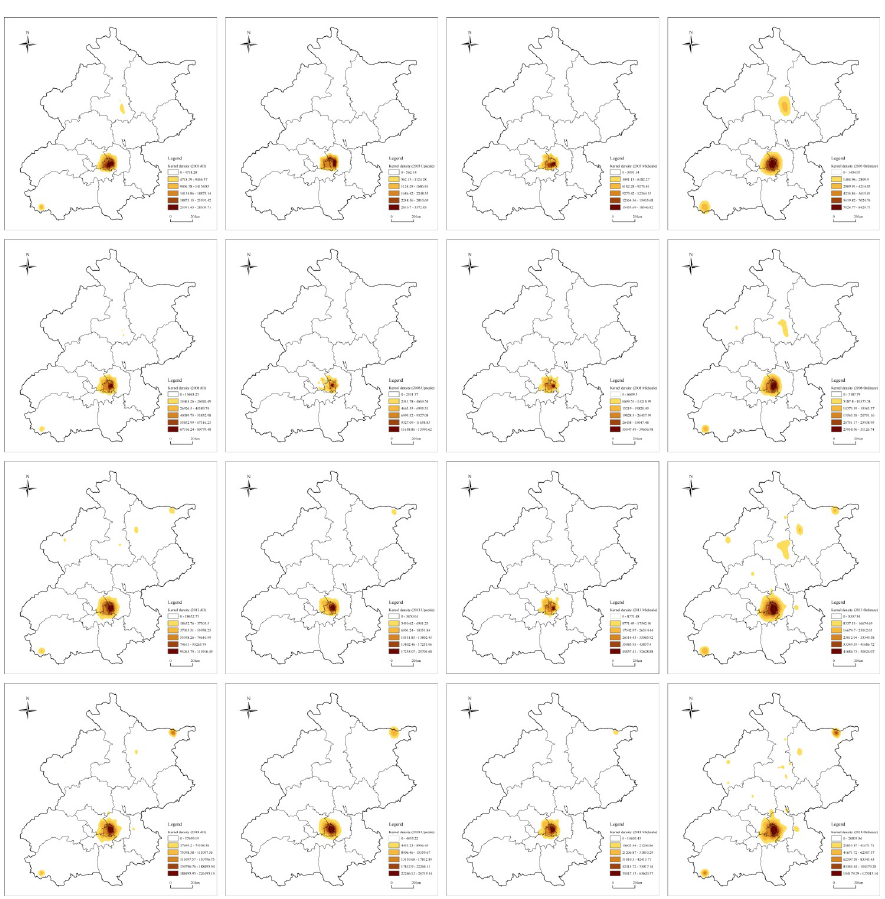
Fig 4. The kernel density estimation map of different types of hotels in Beijing 2003–2018. The color represents the nuclear density of the spatial distribution of different types of hotels in Beijing. The darker the color, the greater the density of the hotels in the area. The map is calculated and drawn by Arc GIS according to formula (2).